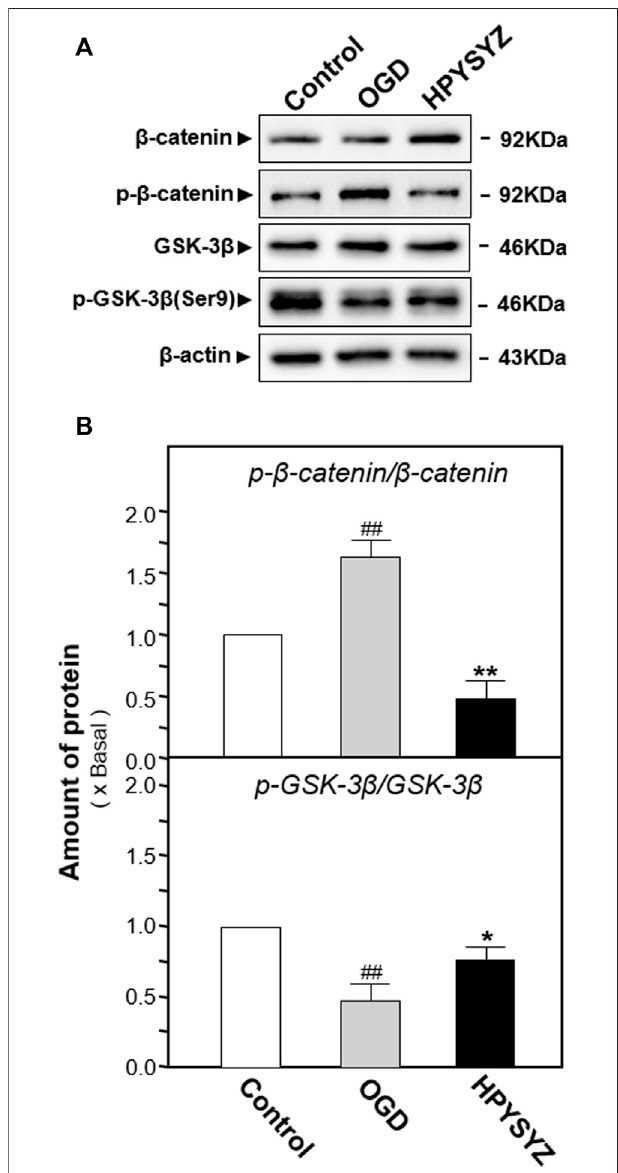
FIGURE11| EthylacetateextractsofsuccinumregulatedtheGSK3 β / β - catenin signaling pathway of HT22 cells under OGD condition. (A) Effect of ethyl acetate extracts of succinum (HPYSYZ) on the expressions of GSK3 β , p-GSK3 β (Ser9), β -catenin, p- β -catenin, and β -actin of HT22 cells under OGD condition were evaluated by Western blotting analysis. The representativeimagesaredisplayed( n =5). (B) Expressionratioofp- β -catenin to β -catenin was calculated, and the expression of β -actin was applied for normalization. Expression ratio of p-GSK3 β (Ser9) to GSK3 β was calculated, and the expression of β -actin was applied for normalization. Values are expressed as the percentage of the control group (no drug treatment group) as mean ± SEM ( n = 5). Comparisons between groups were analyzed by a one-way ANOVA followed by a post hoc Bonferroni test. ## p < 0.01 (compared with the control group), * p < 0.05, and ** p < 0.05 (compared with the OGD model